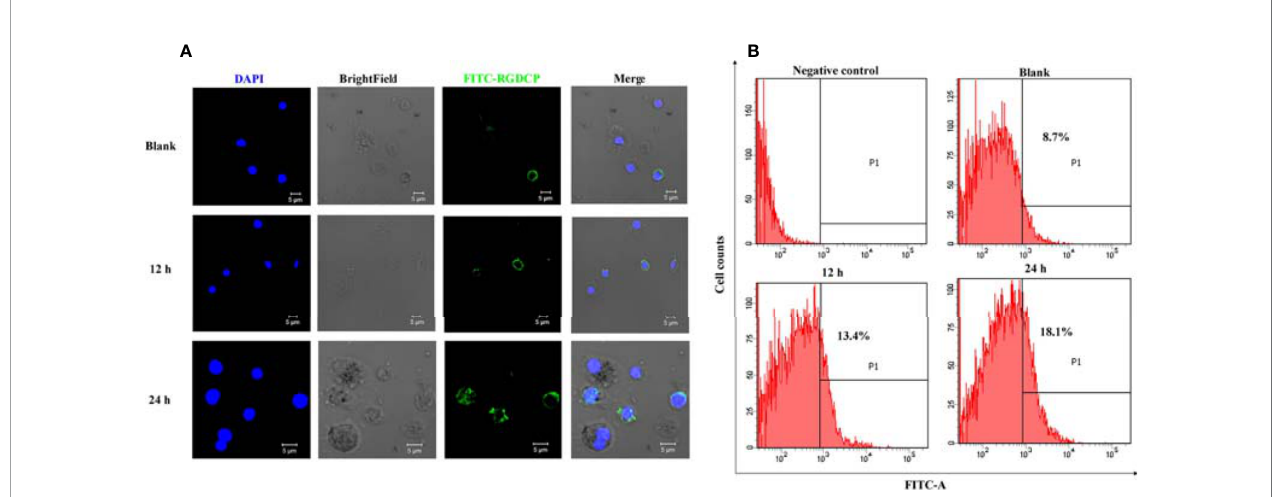
FIGURE 2 | Fluorescent labeling of C. gigas RGD + hemocytes and their response to V. splendidus challenge. (A) Immuno fl uorescence analysis of numerary changes in C. gigas RGD + hemocytes after stimulation with V. splendidus. FITC-conjugated RGDCP-labeled oyster integrins on cell membranes are indicated in green, and the cell nucleus stained with DAPI is indicated in blue. Bar = 5 m m. (B) Flow cytometry analysis of numerary changes in C. gigas RGD + hemocytes after stimulation with V. splendidus. FITC-positive cells and RGD + hemocytes were gated as